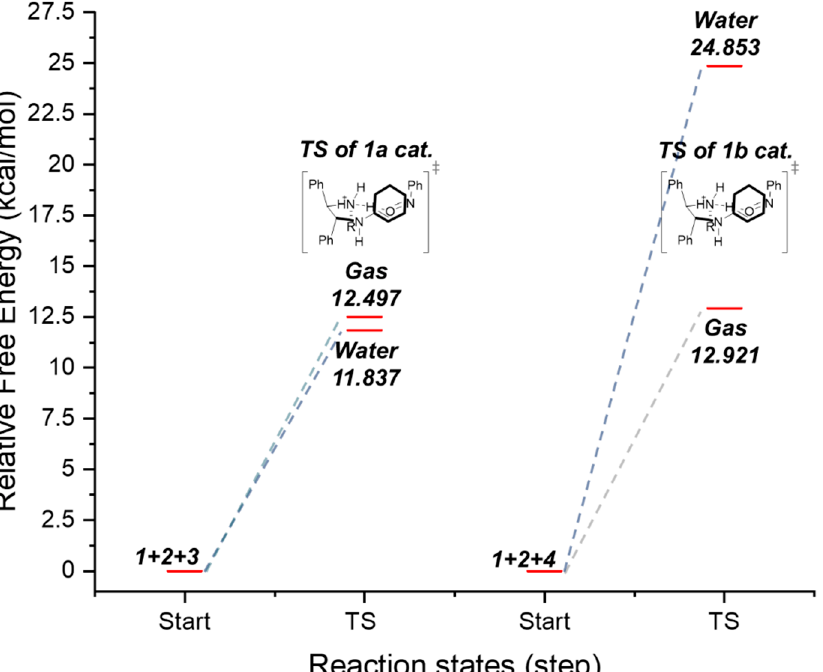
Figure 4. Relative free energy diagram showing proposed catalytic transition states of 1a and 1b catalysts based on the B3LYP/6-31G(d,p) method. The calculations were performed using water and gas conditions. Starting reagents 1, 2, 3, and 4: (1: cyclohexanone, 2: nitrosobenzene, 3: 1a cat., and 4: 1b cat.).